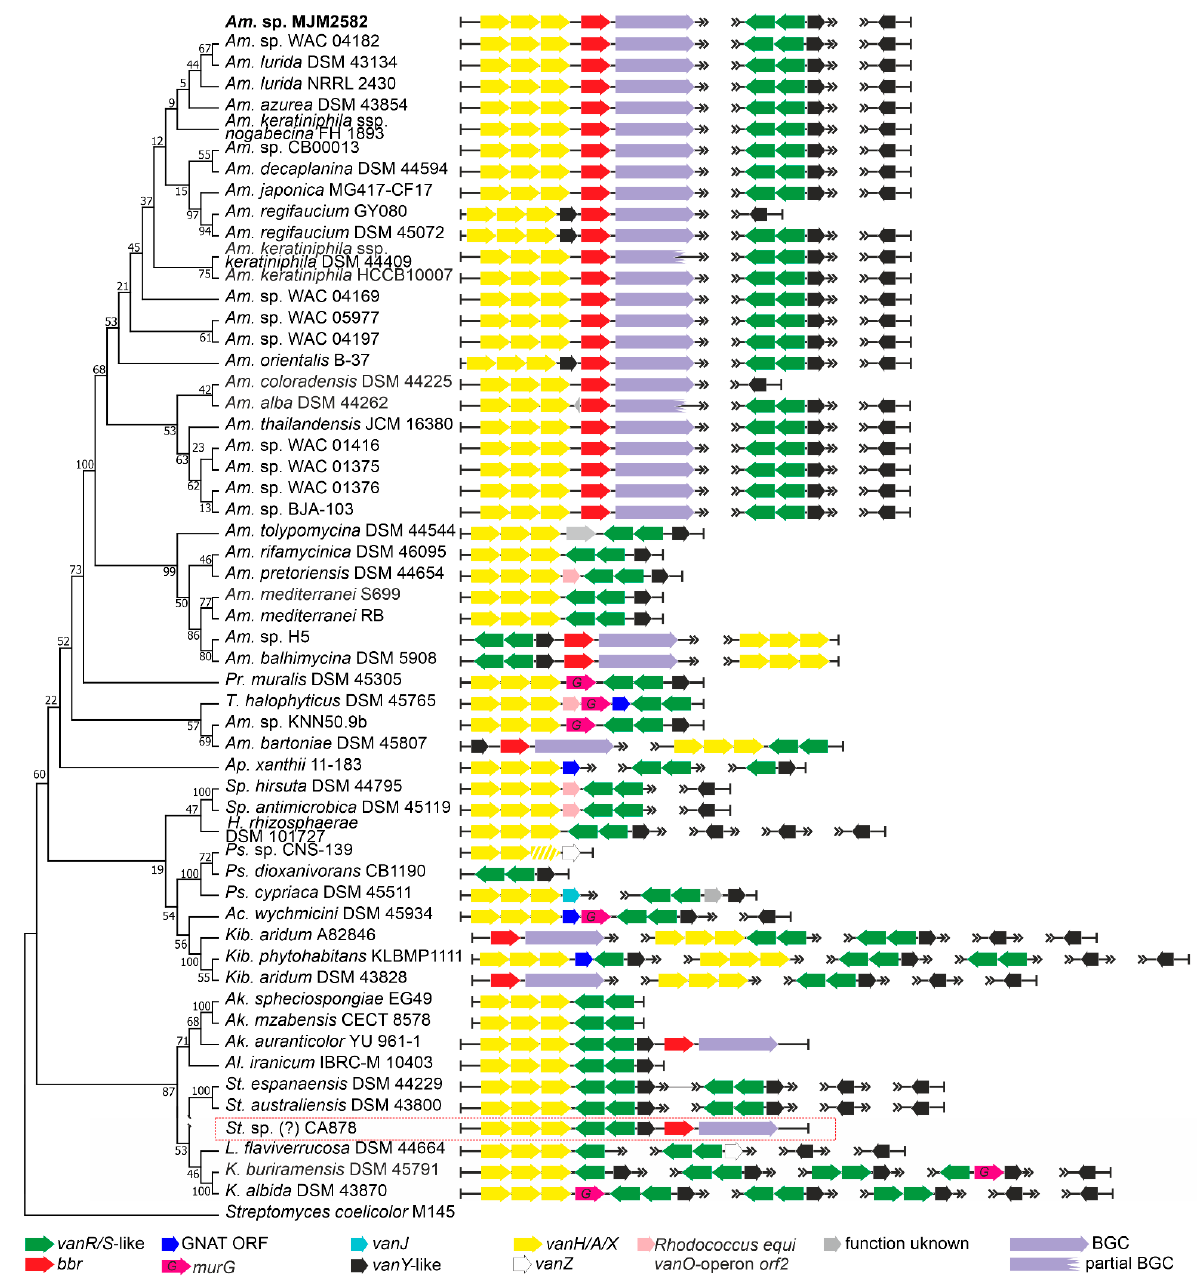
Figure 2. Organization of vlgs found within the set of 55 chosen genomes from Pseudonocardiales spp. Maximum Likelihood phylogenetic tree of the 16S rRNA genes of the corresponding species (see Section 4 for details) served as a phylogenetic framework for the scheme. Amycolatopsis sp. MJM2582 (in bold at the top of the figure) is outside the framework due to the lack of a full 16S rRNA gene in the corresponding genome assembly. vlgs from the metagenomic CA878 BGC (highlighted with red frame) were arbitrary introduced in this scheme since the retrieved sequences likely belong to Saccharothrix spp. Names of the Pseudonocardiales genera were abbreviated according to ESM Table S1. The legend below the figure explains the color-coding of the scheme. Please refer to the text for the role of the single genes. Pseudogenes are shaded.